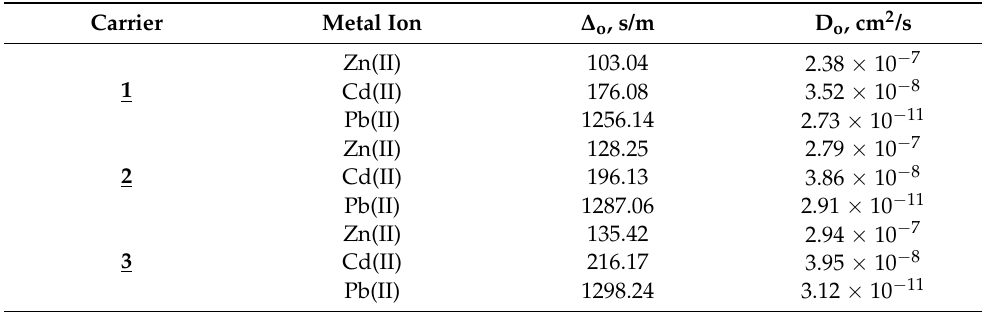
Table 6. Diffusion coefficients for competitive transport of Zn(II), Cd(II), and Pb(II) ions through PIMs with 1-alkyltriazole ( 1 – 3 ).